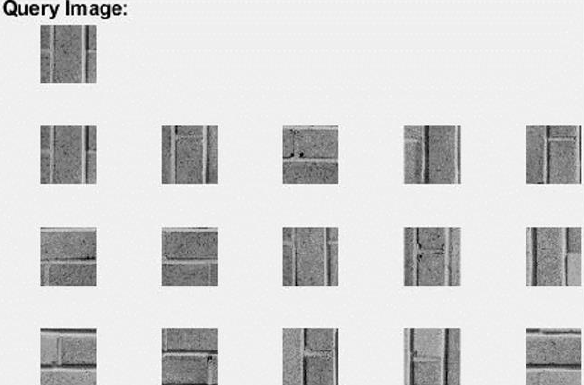
Figure 7. Retrieval result of a query image from Brodatz